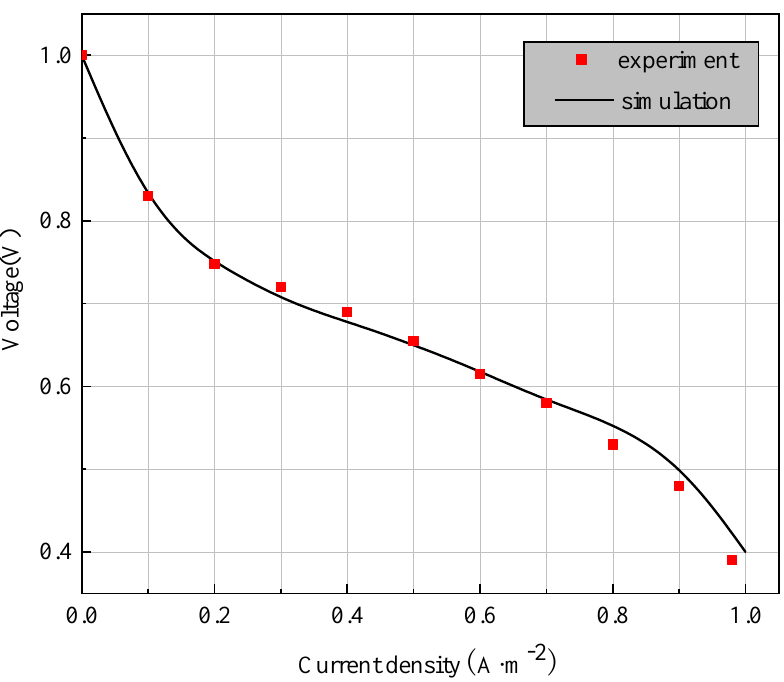
Figure 4. Comparison of polarization curves between simulation results and experimental data.